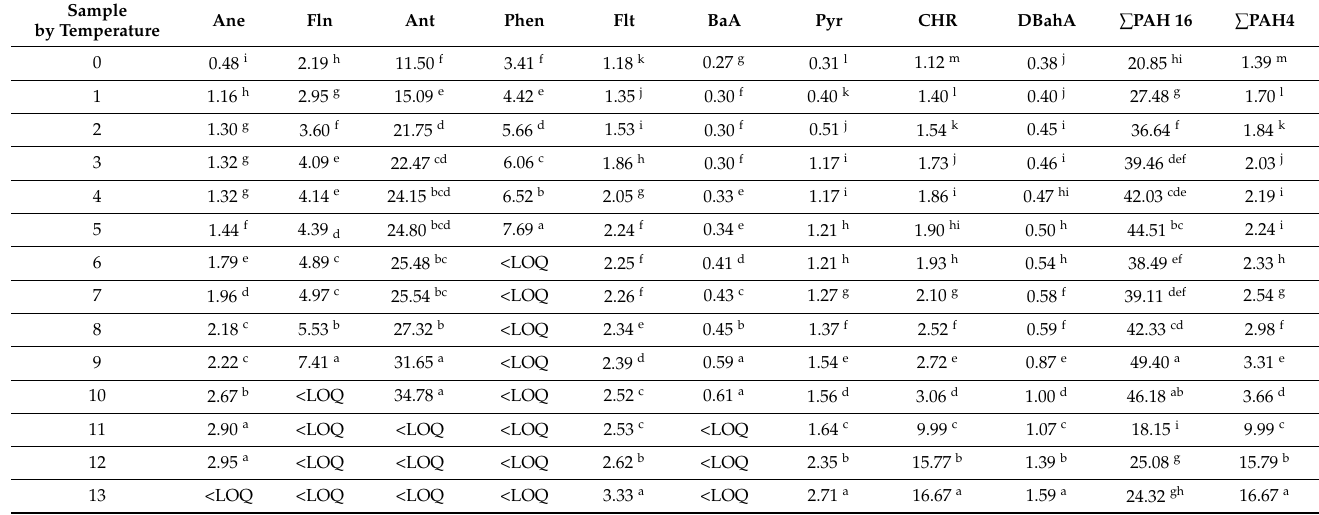
Table 3. PAH values ( µ gkg − 1 ) in barley and malt samples exposed to different temperatures for 1